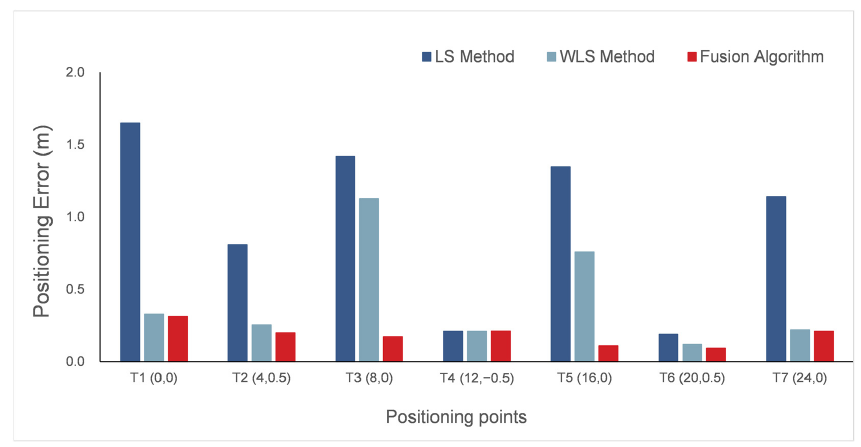
Figure 9. RMS error of different points in Scene A.